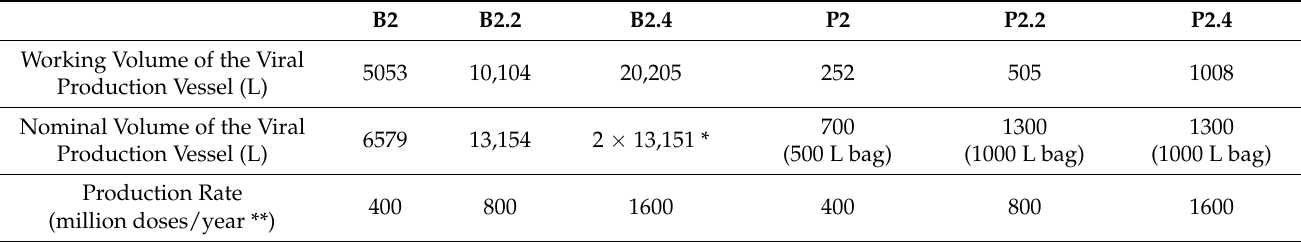
Table 12. Working and nominal volume of the bioreactor employed in the viral production step for different process scales.